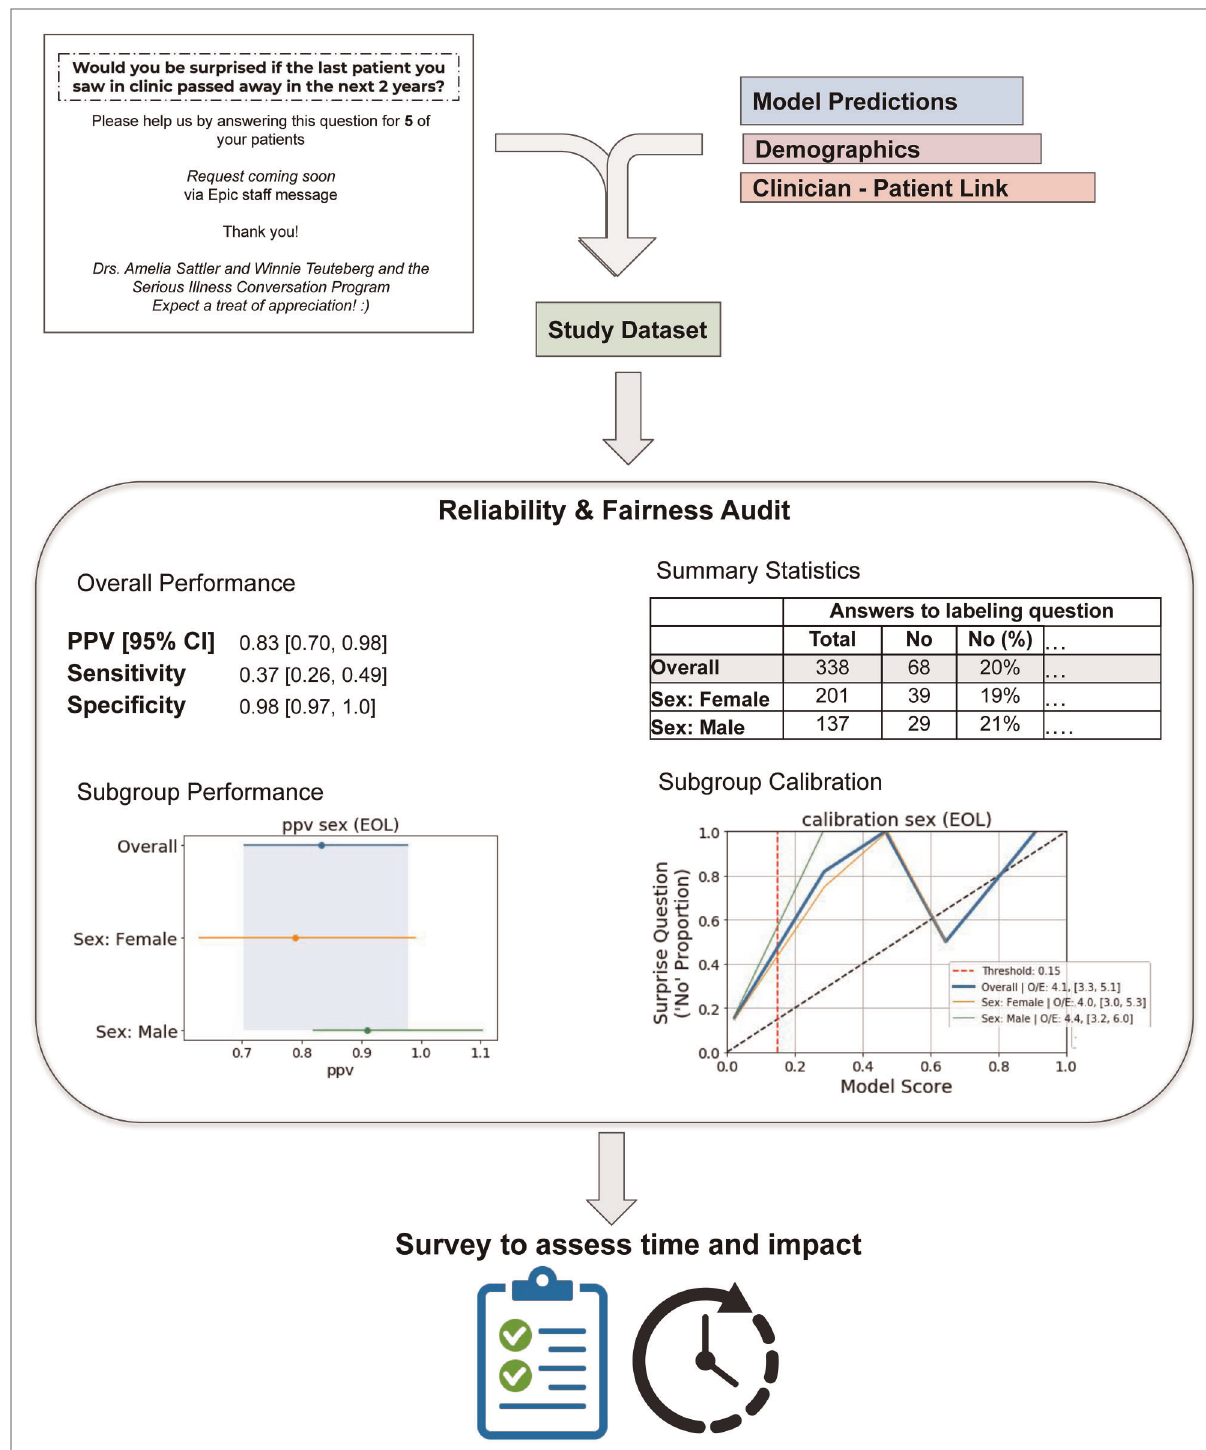
FIGURE 1 Overview of audit process. Results and plots listed are for the Epic End-of-life Index Low Threshold for Primary Care. The “ labeling question ” under Summary Statistics is “ Would you be surprised if this patient passed away in 2 years? ”